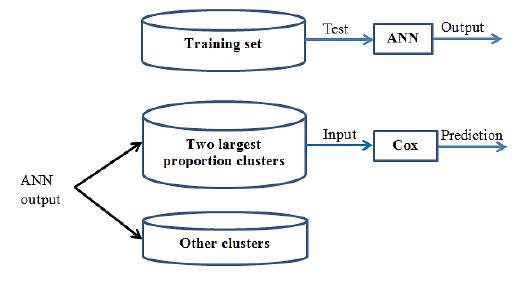
Fig. 1. The framework of the proposed